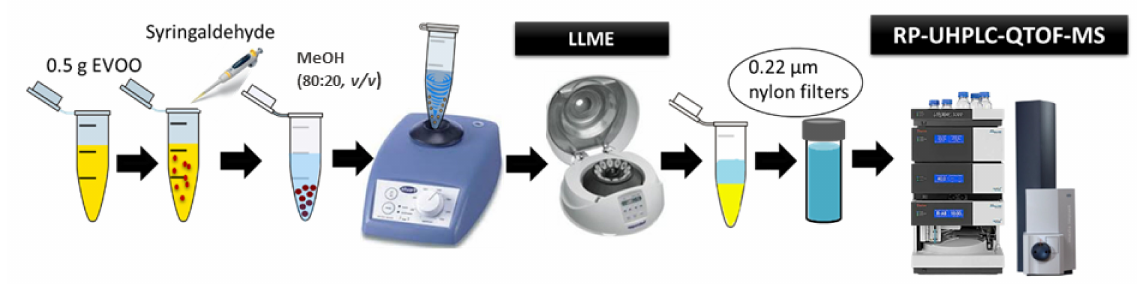
Figure 8. Schematic representation of the LLME-RP-UHPLC-QTOF-MS methodology applied in the analysis of